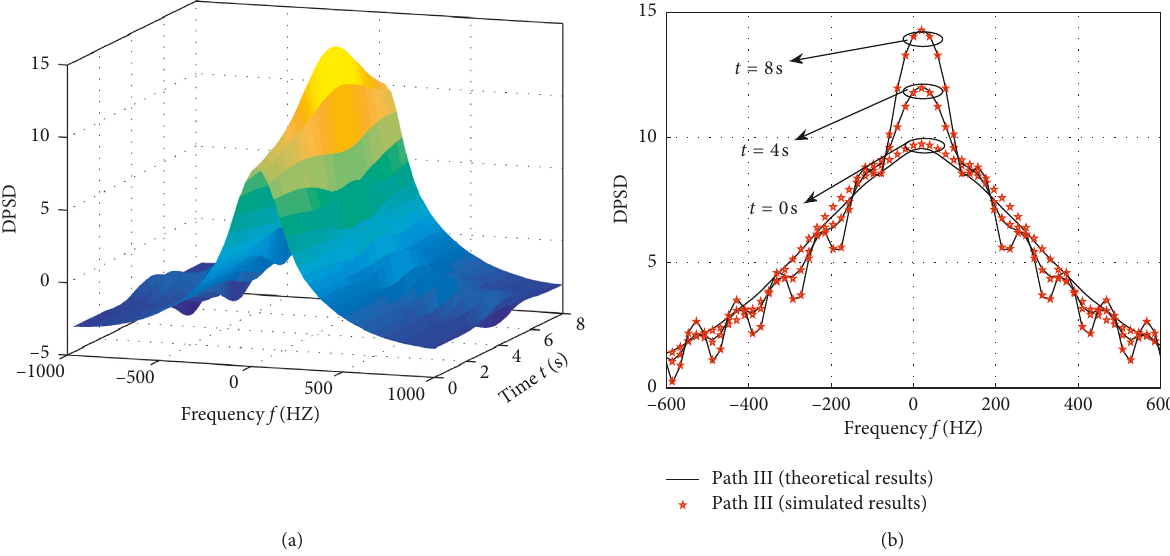
Figure 7: (a) Theoretical 3D DPSD and (b) theoretical and simulated DPSDs at different time instants for Path